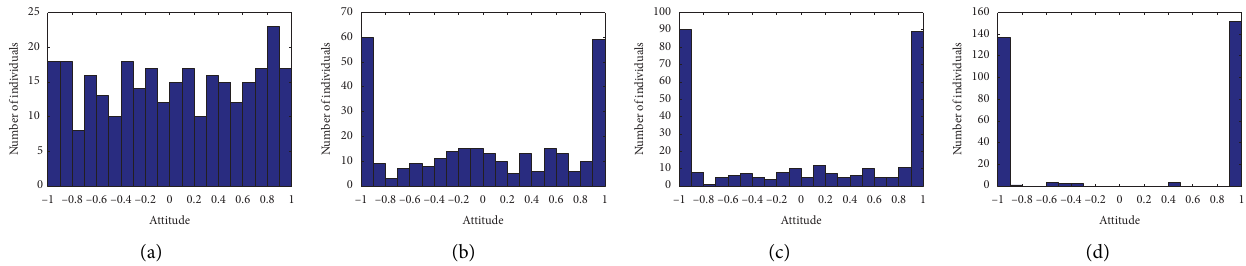
Figure 8: Individual attitudes under different interaction times. (a) Time � 0. (b) Time � 50. (c) Time � 100. (d) Time � 400.